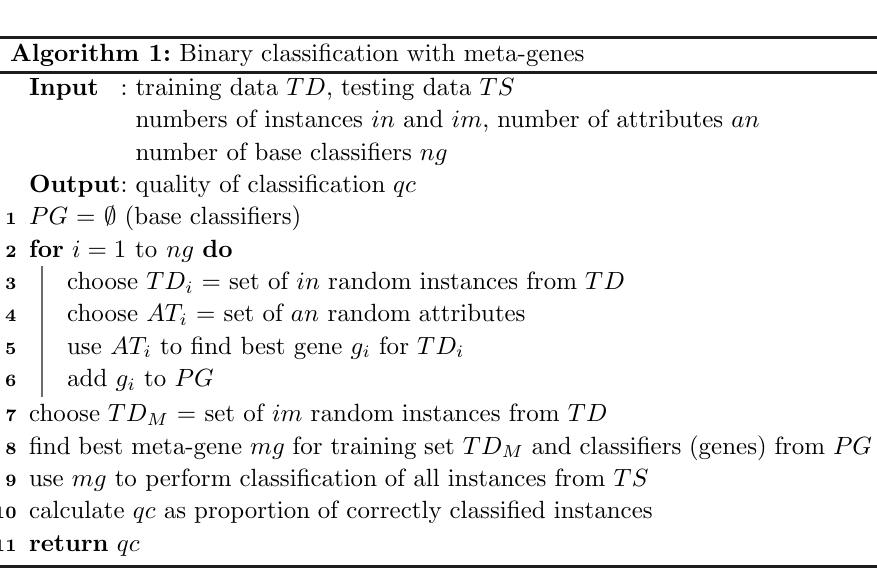
Algorithm 1: Binary classification with